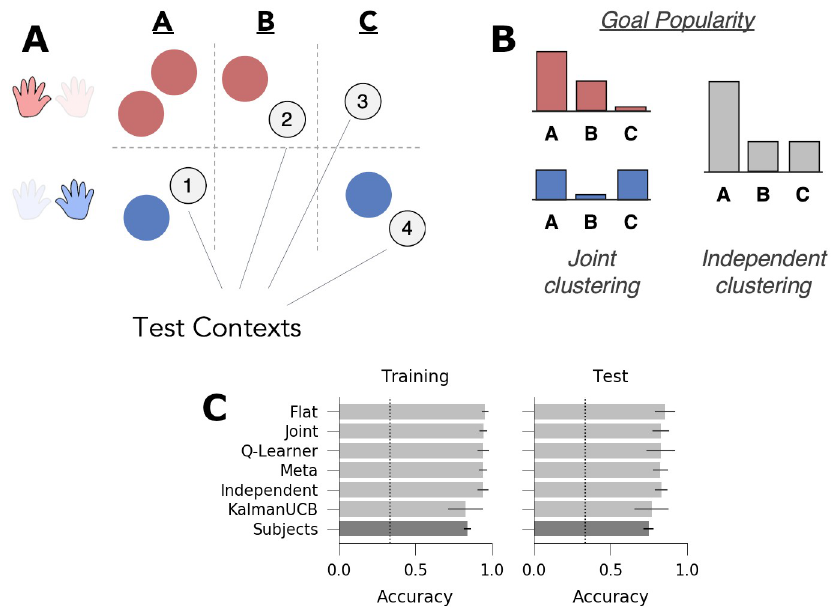
Fig 8. Experiment 3: Ambiguous structure. A : Subjects saw five contexts (circles) during training, each paired with one of two mappings ( red : high popularity, blue : low popularity) and one of three goals (A, B, or C). The most popular goal A was paired with multiple mappings, but the other goals B and C were paired with a single mapping each, making the structure more ambiguous. Subjects learned to navigate in an additional four novel test contexts following training (grey circles). B : Goal popularity in the training environment as a function of mapping (as tracked by the joint agent, left) and collapsed across all contexts (as tracked by the independent agent, right). C : Goal accuracy of models (light grey) and human subjects (dark grey) across all trials in the training and test contexts. Chance performance denoted with dotted line. Error bars denote standard deviation.